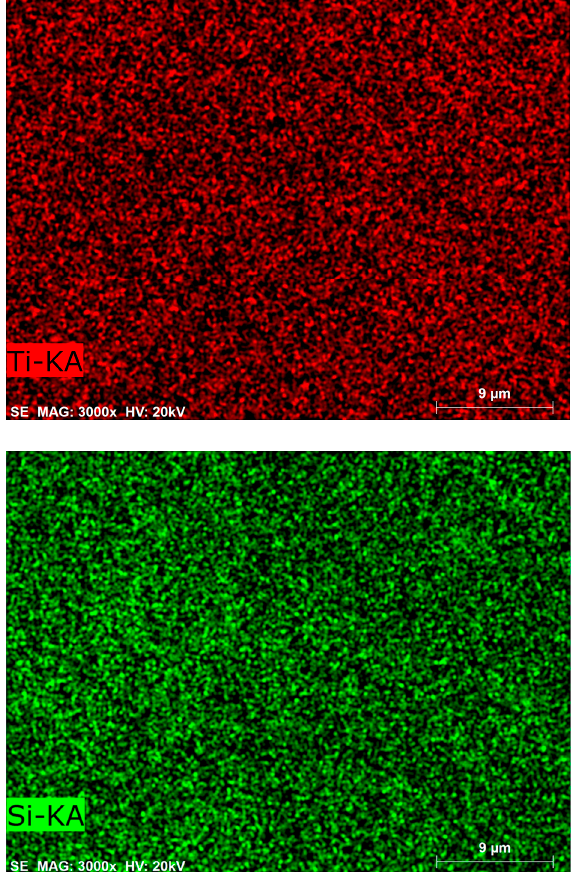
Figure 7. Mapping of titanium and silicon in the photocatalytic membranes prepared.